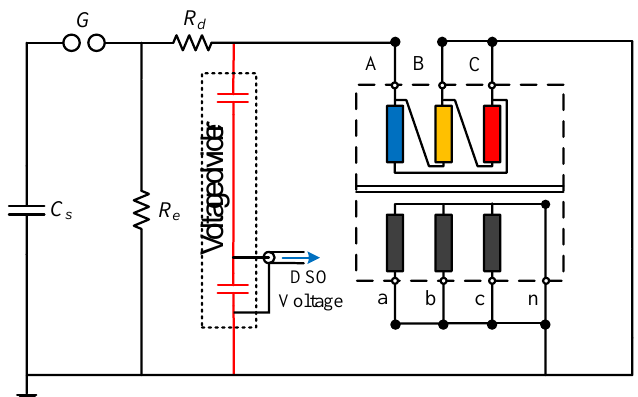
Figure 22. Equivalent circuit of the completed test system for the lightning impulse test of the distribution transformer winding.